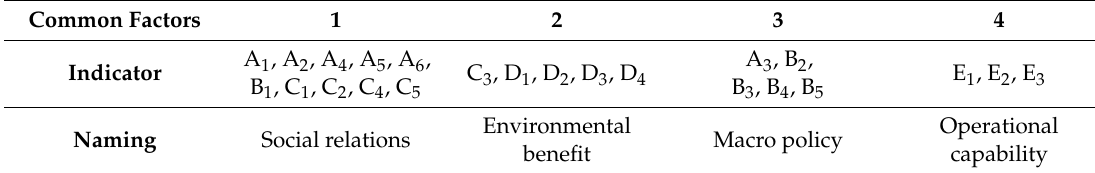
Table 9. Public factor extraction after dimensionality